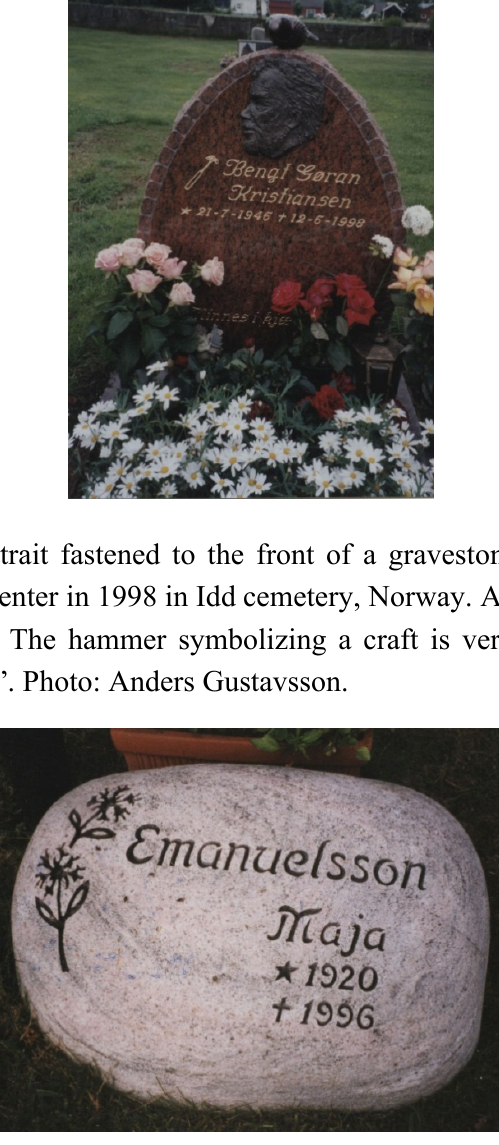
Figure 2. A woman’s name inscribed to the right in 1996, with the space on the